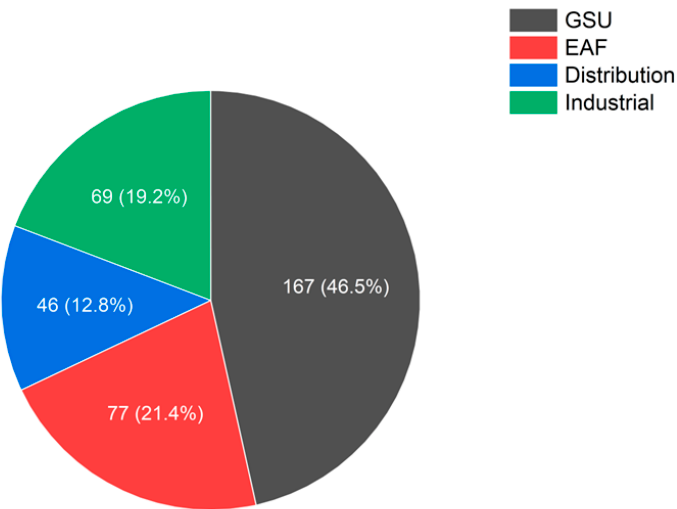
Figure 1. The operation type distribution of the transformers included in the study group.